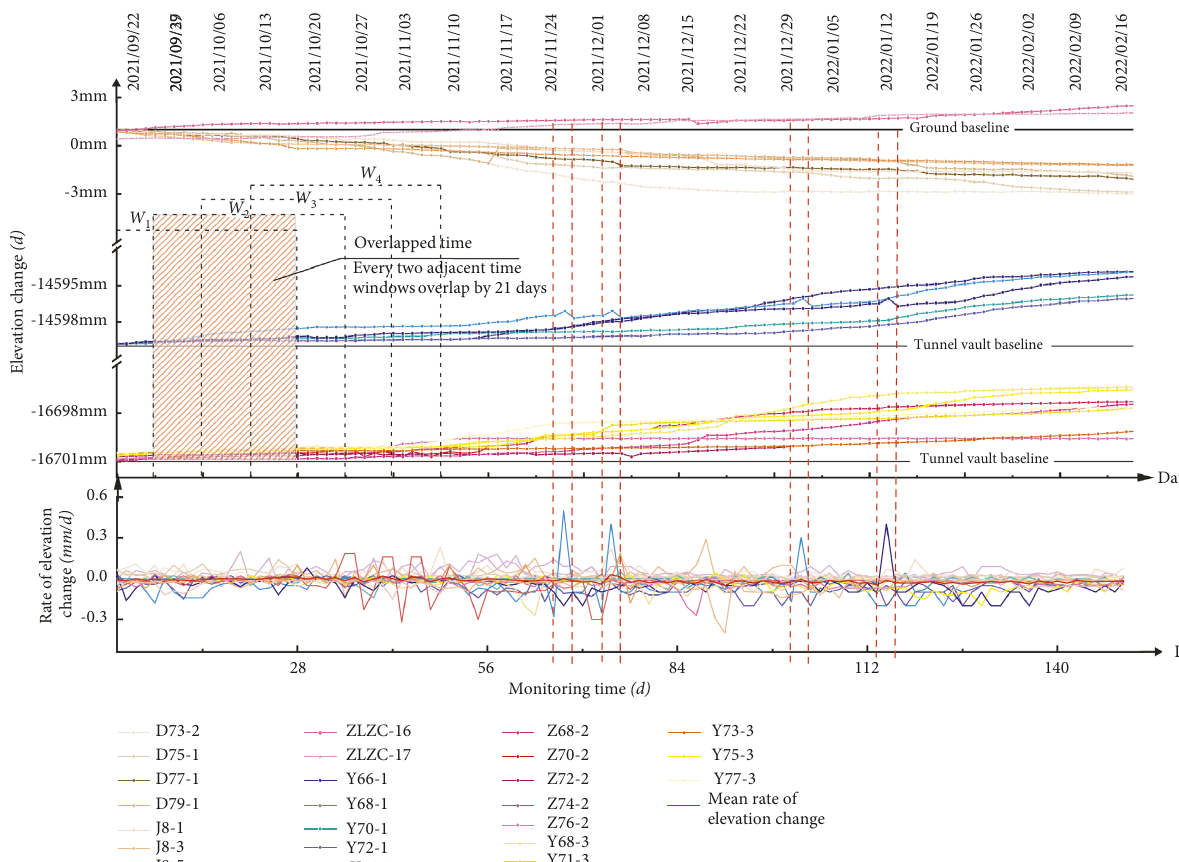
Figure 7: Time series and window division of some monitoring